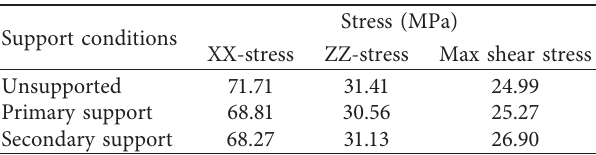
Figure 12: Displacement and velocity of surrounding rock. (a) Displacement. (b) Delocity. Table 4: Peak stress of surrounding rock under different sup- porting